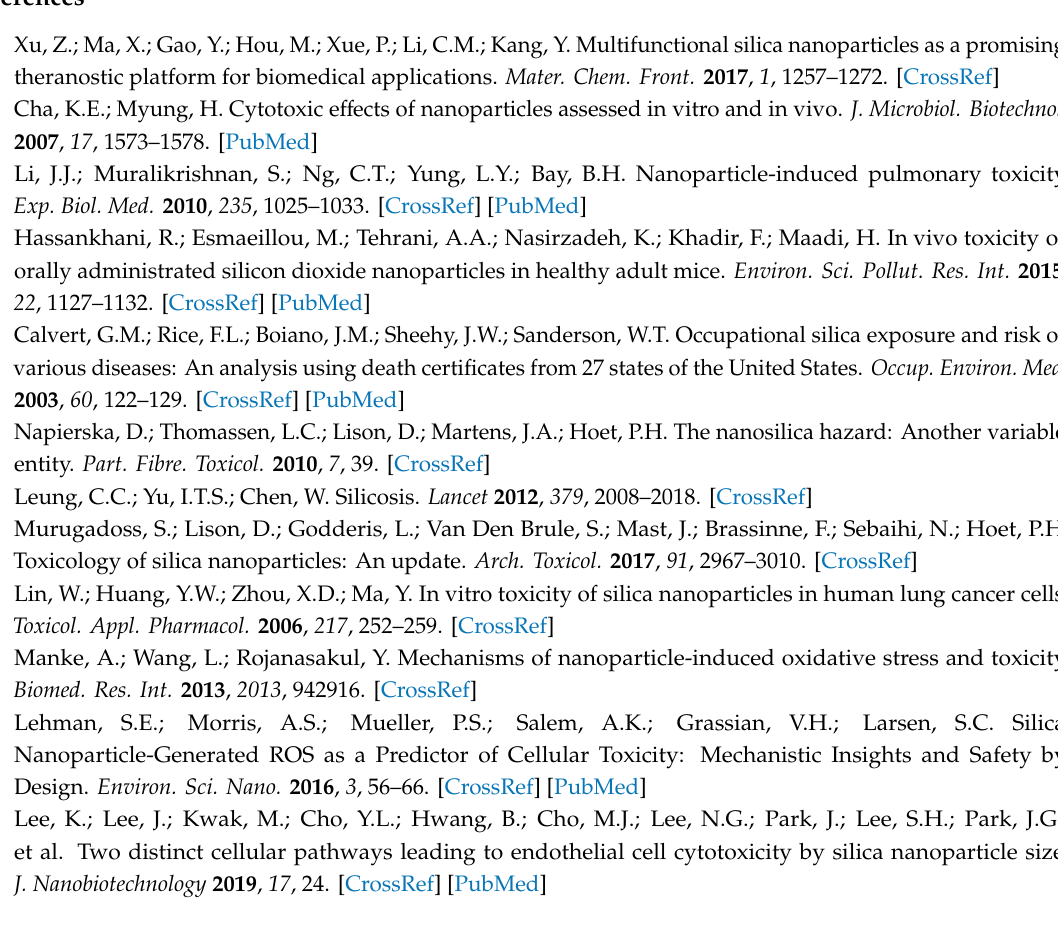
Figure S1: Cell viability in the presence of silibinin in NCI-H292 cells, Figure S2: The e ff ects of silibinin on TXNIP expression at the basal condition, Figure S3: The e ff ects of SiONPs on TXNIP expression at the basal condition, Figure S4: Histopathology for lung tissue (magnification